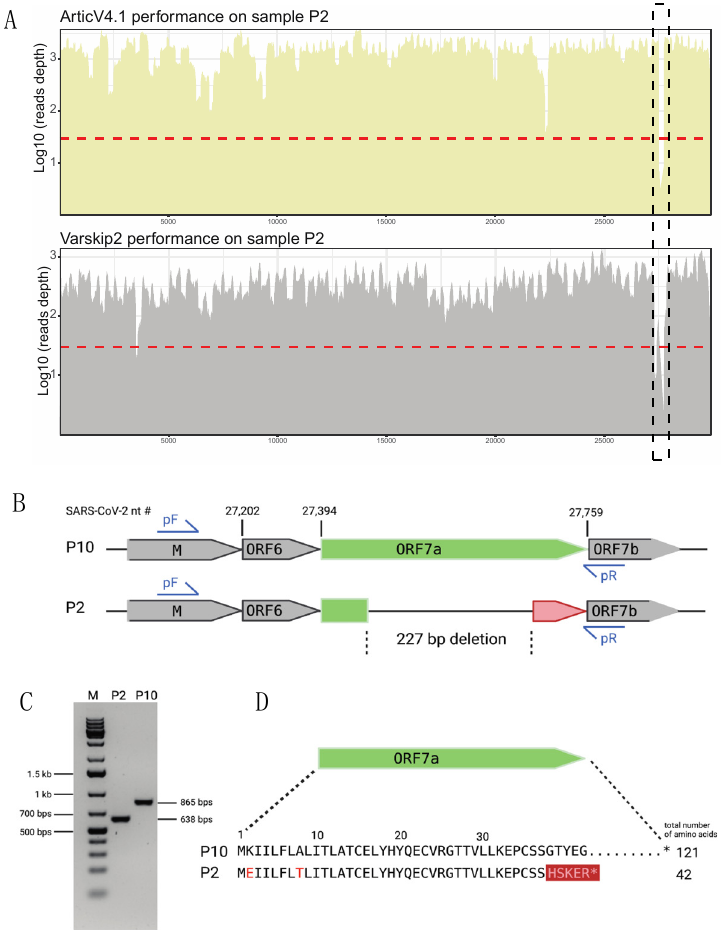
Figure 4. A 227 bp deletion observed in the ORF7a region of one of the Delta samples, P2. ( A ) Amplicon sequencing using both ArticV4.1 and VarSkip2 indicates a deletion in the ORF7a region of sample P2. ( B ) Schematic diagram of the SARS-CoV-2 genome of P2 and a no-deletion Delta sample, P10, highlighting the 227 bp ORF7a deletion observed in P2 (created with BioRender.com). Primers pF and pR were used for RT-PCR to confirm the deletion. The SARS-CoV-2 nt # denotes the nucleotide position in the reference genome (GenBank accession NC_045512.2). ( C ) Gel electrophoresis results of the PCR products showed the expected size difference between P2 and P10. ( D ) Schematic diagram of the Sanger sequencing results showing the predicted ORF7a amino acid sequence of samples P2 and P10 (created with BioRender.com). The resulting frameshift mutation and stop codon in P2 is highlighted in red.